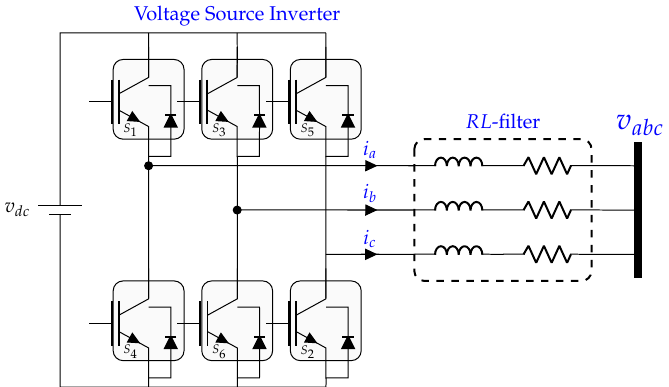
Figure 1. Schematic of a voltage source converter (VSC) that interfaces a battery connected to an ac